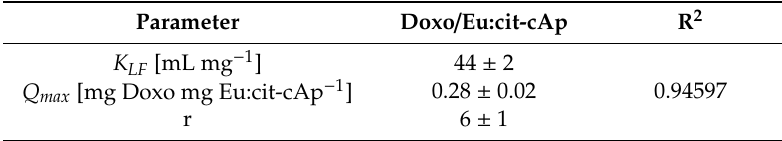
Table 1. Adsorption parameters calculated from nonlinear fitting of experimental data according to the Langmuir − Freundlich